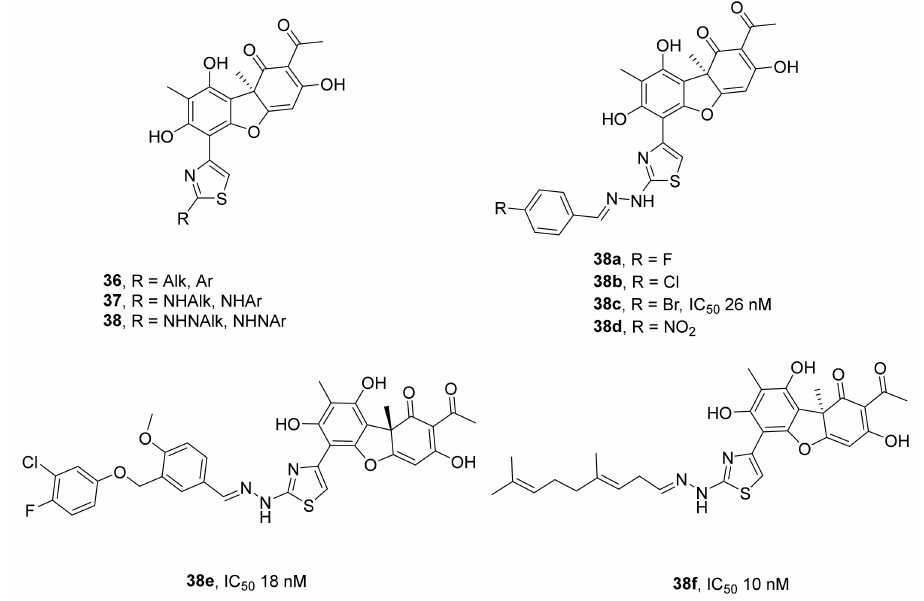
Figure 10. Thiazole derivatives of usnic acid as inhibitors of